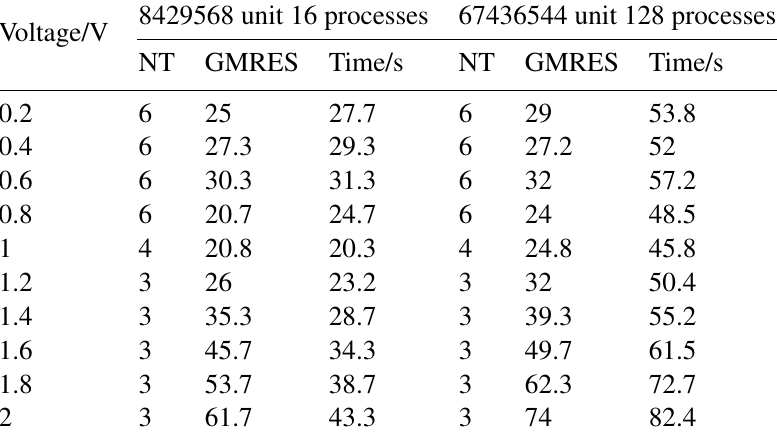
Fig. 6 MOSFET output characteristic curve. Table 1 Numerical simulation of PN junction diffusion